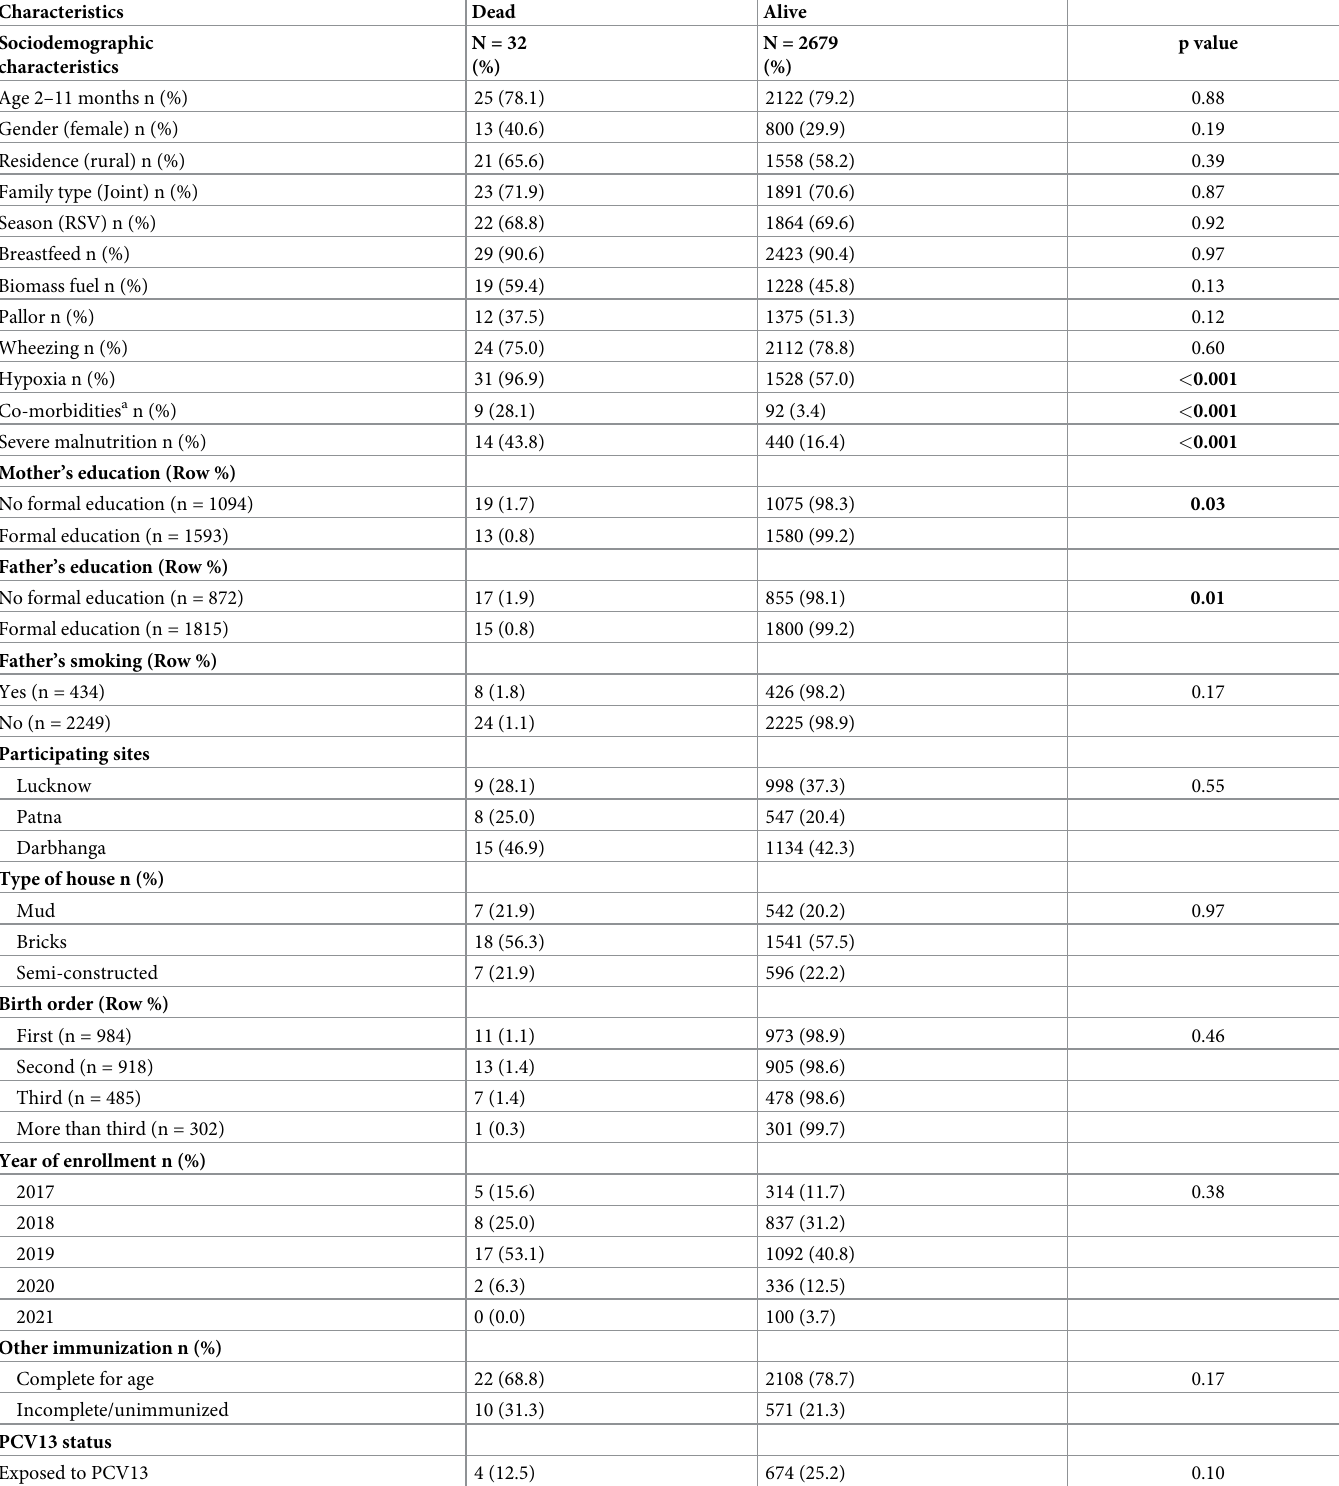
Table 4. Comparison of sociodemographic and clinical variables among the cases of CAP with and without hospital mortality.